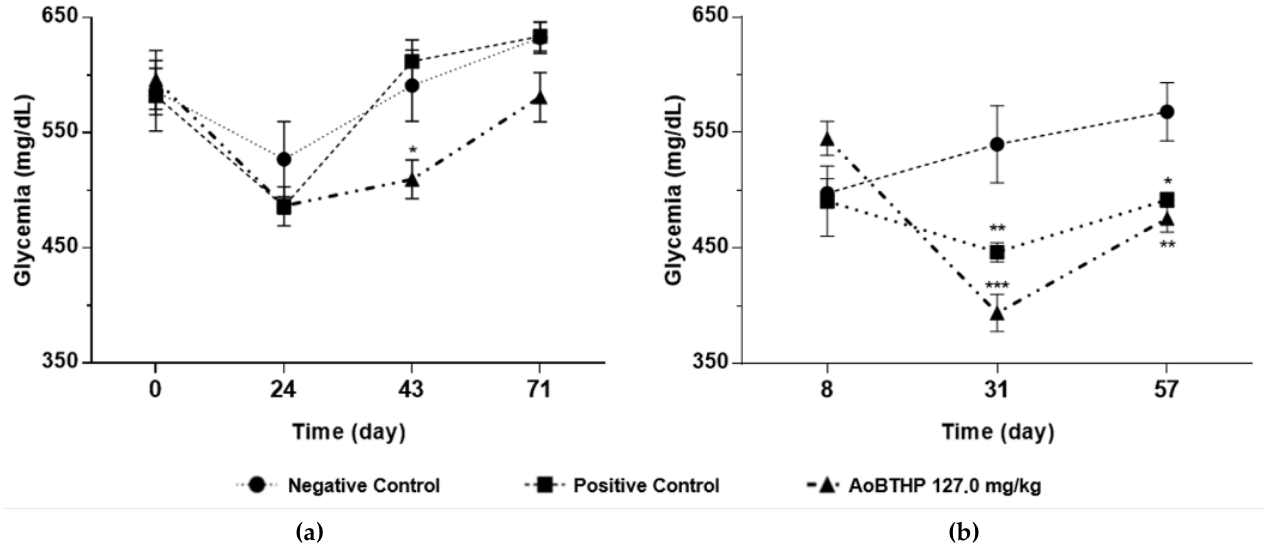
Figure 3. ( a ) Non-fasting glycemia values; ( b ) fasting glycemia values of control groups and 127.0 mg/kg AoBTHP. * p < 0.05 vs. negative control, ** p < 0.01 vs. negative control, *** p < 0.0001 vs. negative control.